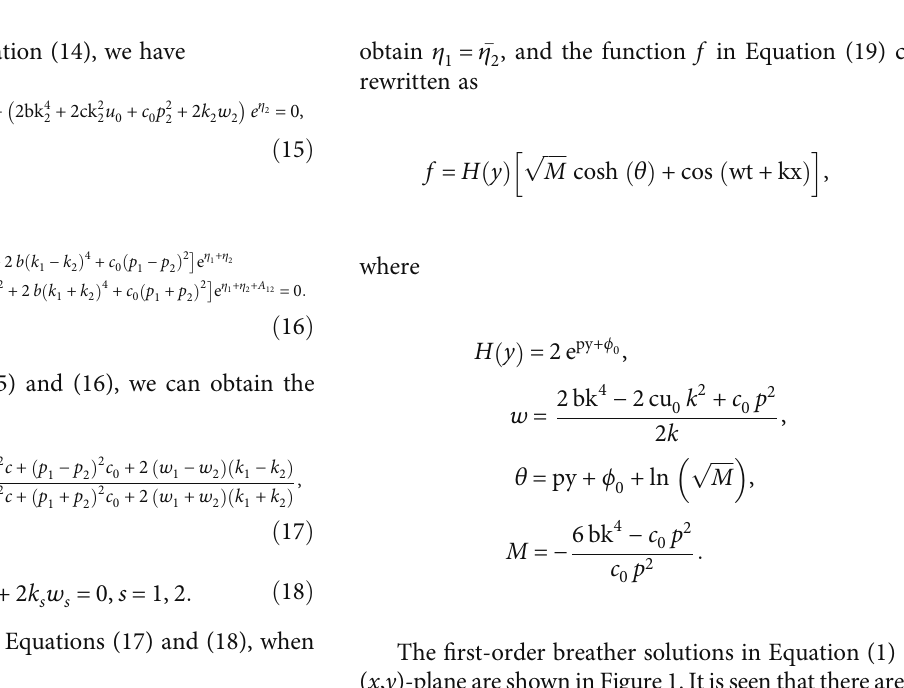
Figure 1: Two types of breather solutions in Equation (1) with parameters c breather with u 0 = 2 and c = − 1 . (b) Dark-type breather with u 0 = − 2 and c = 1